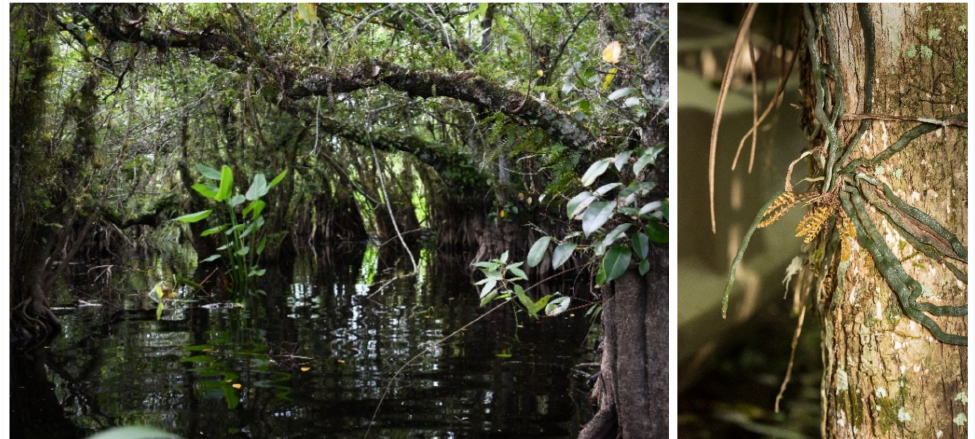
Figure 1. Campylocentrum pachyrrhizum is found in the Fakahatchee strand, which consists of sea- sonally flooded swamps and sloughs ( Left ). Easily mistaken for the ghost orchid, the ribbon orchid ( Right ) has roots that are greenish-grey and appear as though they “ripple”. Left photo courtesy of Larry